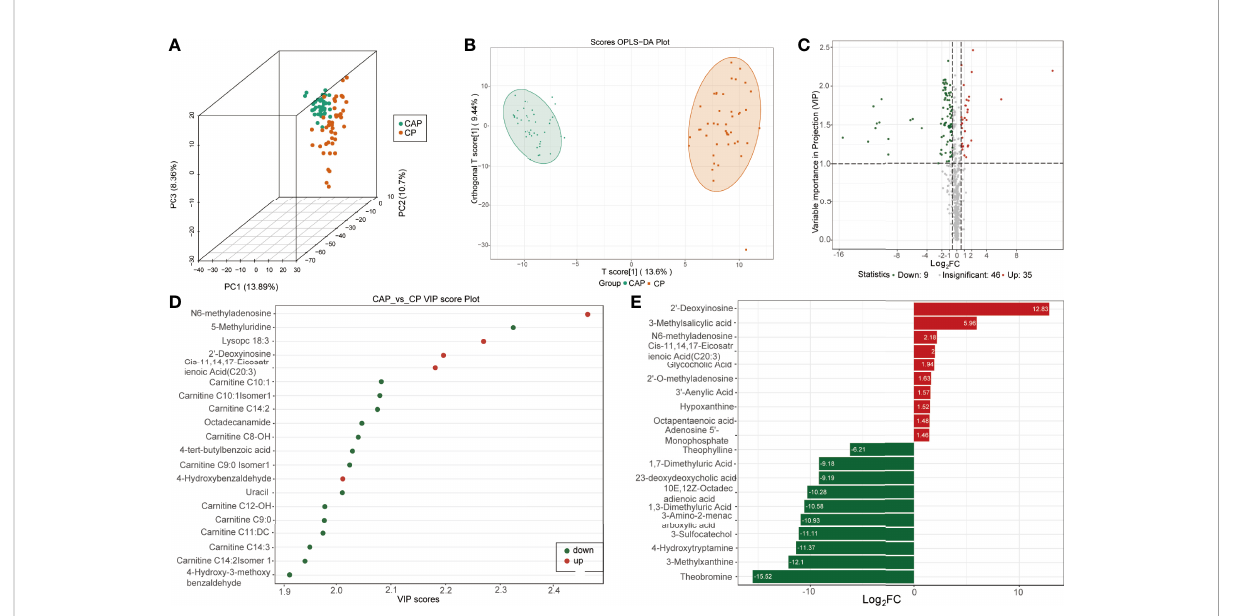
FIGURE 2 Identi fi cation of differentially expressed metabolites between COVID-19 patients and community-acquired pneumonia. (A) Score plots of three- dimension principal component analysis (3D-PCA) discriminating between the metabolic pro fi les of community-acquired pneumonia (CAP) and COVID-19 patients (CP). (B) Orthogonal partial least-squares discriminant analysis (OPLS-DA) score plot of CAP and CP. (C) Volcanic map of differentially expressed metabolites between CAP and CP. Red dots represent upregulated metabolites, gray dots represent unchanged metabolites, and green dots represent downregulated metabolites. (D) The top 20 differentially expressed metabolites ranked by the value importance plot (VIP). (E) The top 20 differentially expressed metabolites ranked by the log2 fold change (Log2